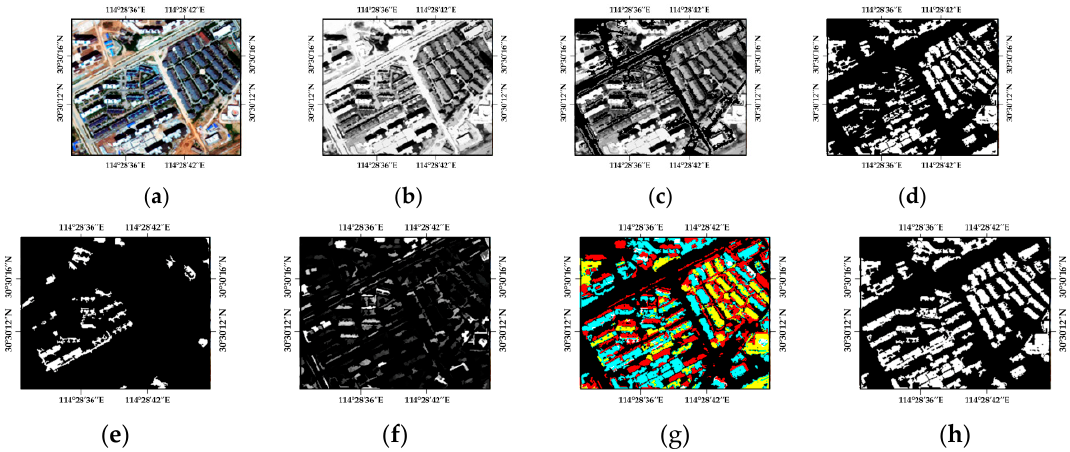
Figure 4. Example showing the steps of the proposed strategy: ( a ) example image; ( b ) the image obtained after image denoising; ( c ) the input image I ; ( d , e ) the building maps obtained from MABI bright and MABI dark , respectively; ( f ) MASI feature image; ( g ) overlay image of the obtained buildings and shadows, with high ‐ MABI in yellow, low ‐ MABI and MABI dark in blue, and shadows in red; ( h ) the final results of the proposed method.